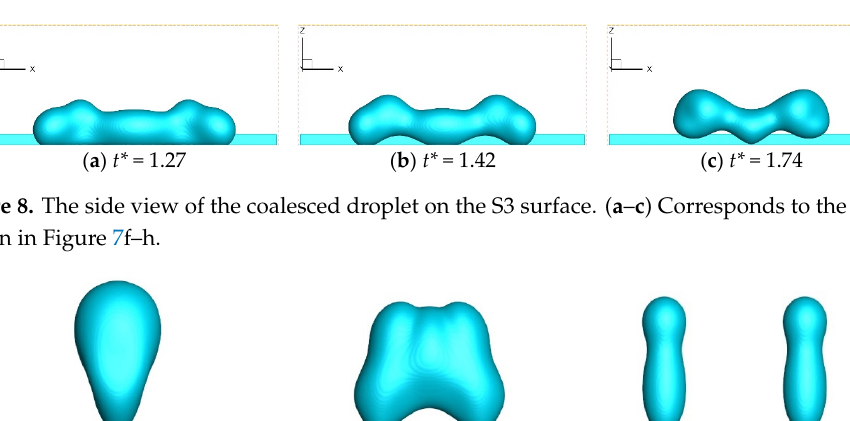
Figure 7. Snapshots of two droplets simultaneously impacting the S3 surface at L x * = 1.67. The morphologies at different moments are illustrated in ( a – h ).